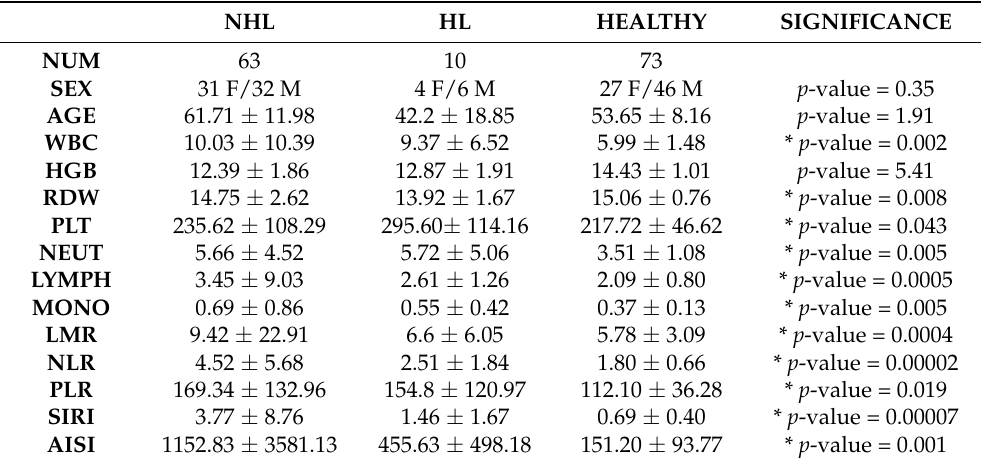
Table 1. Clinical parameters between the three groups under observation (NHL, HL and Sani). Kruskal–Wallis test, p < 0.05 as statistically significant, indicated by